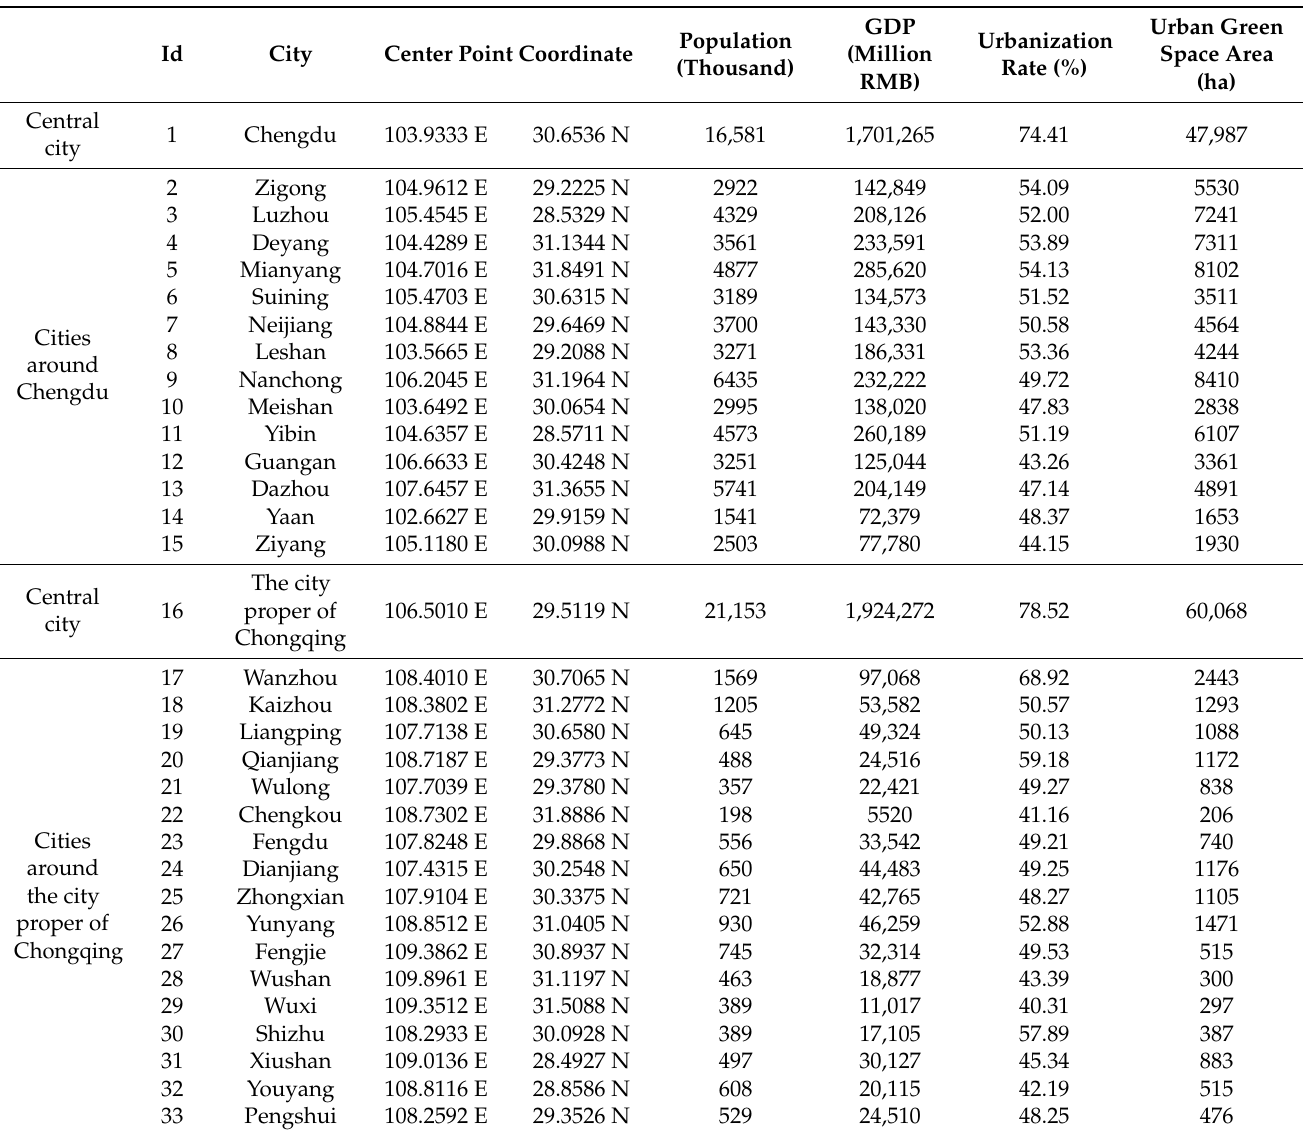
Table 1. Composition and socio-economic data of the Chengdu-Chongqing Megalopolis (data source: published yearbooks).